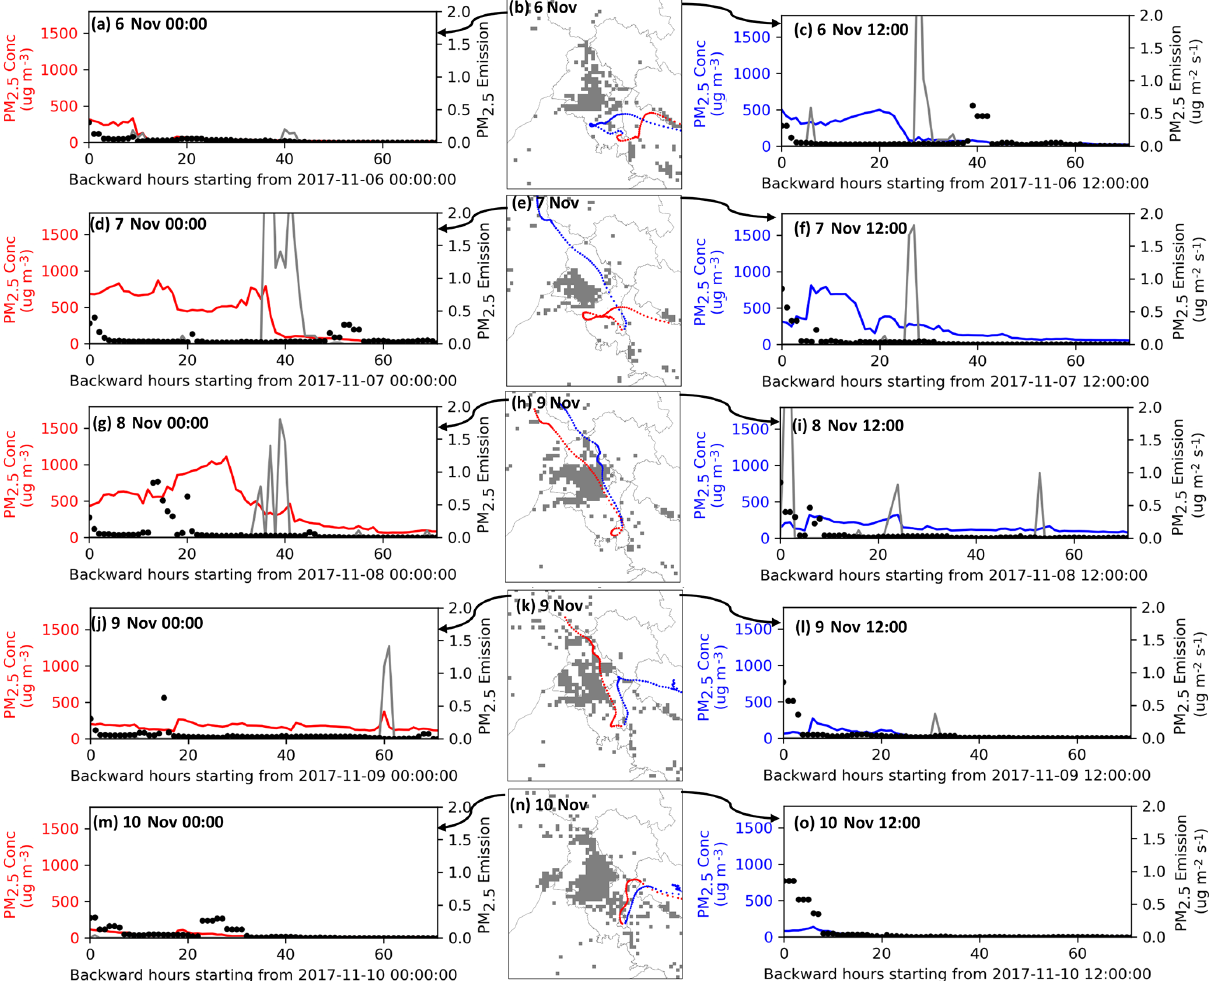
Figure 7. Back trajectory plots of PM 2 . 5 concentration (base scenario) on different days for 72h: in each row, the map shows the back trajectory path for the mass mean location for releasing 10000 particles over eastern Delhi at 00:00UTC (red line) and 12:00UTC (blue line), where the underlying map shows FINN grid cells on that day. Time series show PM 2 . 5 concentrations (primary y axis) and emis- sions (secondary y axis) for anthropogenic (black dots) and FINN (gray line) inventories along the path. Dates are (a–c) 6 November, (d–f) 7 November, (g–i) 8 November, (j–l) 9 November, and (m–o) 10 November. The times 00:00 and 12:00UTC denote 05:30 and 17:30 local time,